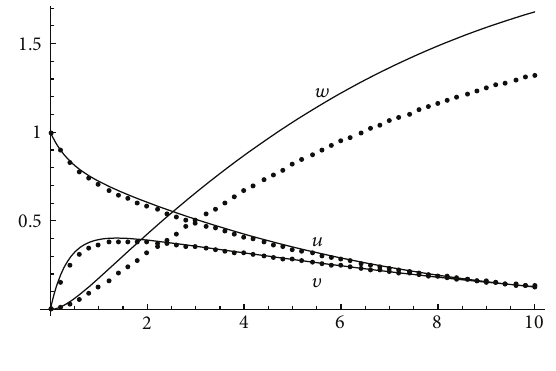
Figure 4: Profile of the normalized concentrations of the substrate 𝑢 , enzyme-substrate complex 𝑣 , and product 𝑤 for 𝑘 and 𝜀 = 0.6 , 𝛼 1 = 1.0 , 𝛼 2 = 0.95 , and 𝛼 3 = 0.95 (solid line); 𝛼 1 = = 𝛼 = 1 (dotted line). 𝛼 2 3